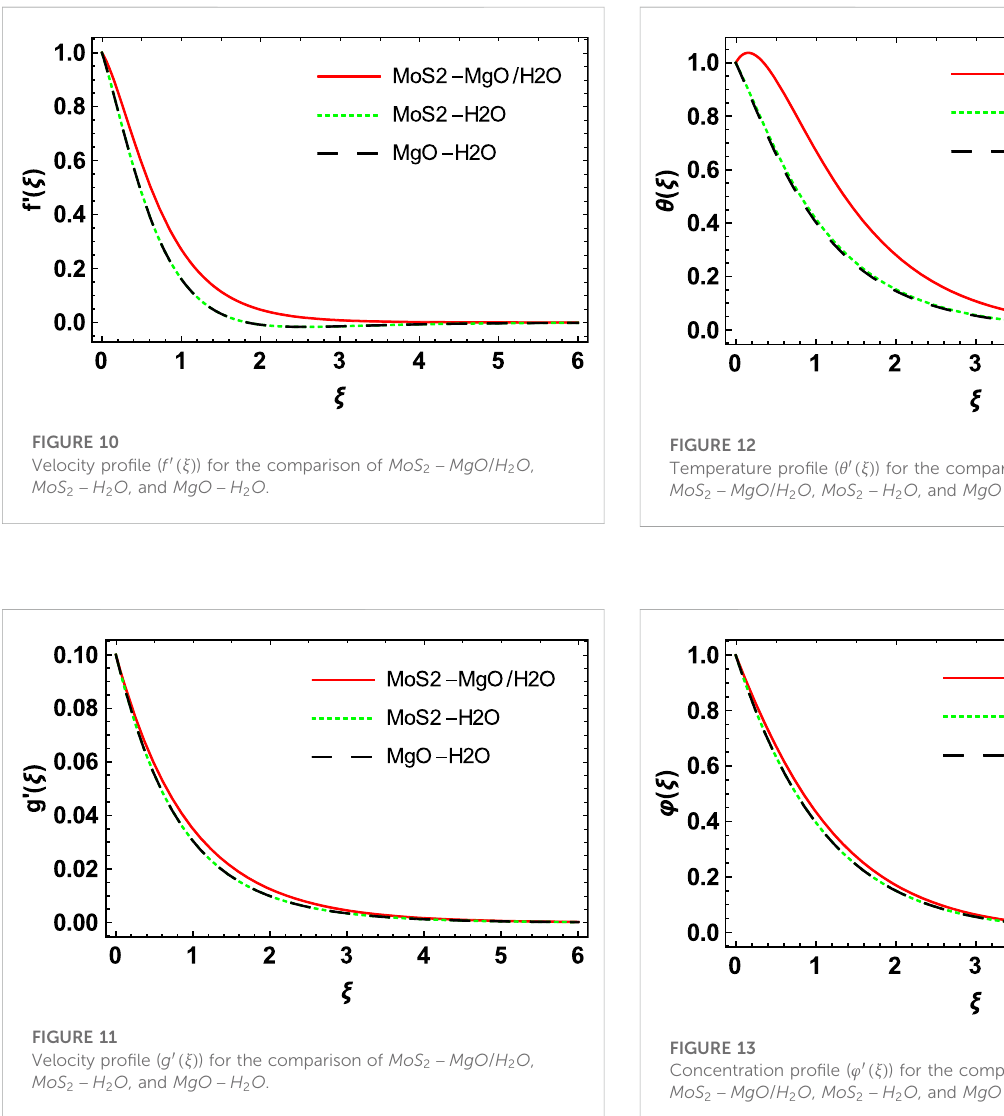
FIGURE 13 Concentration pro fi le ( φ ′ ( ξ ) ) for the comparison